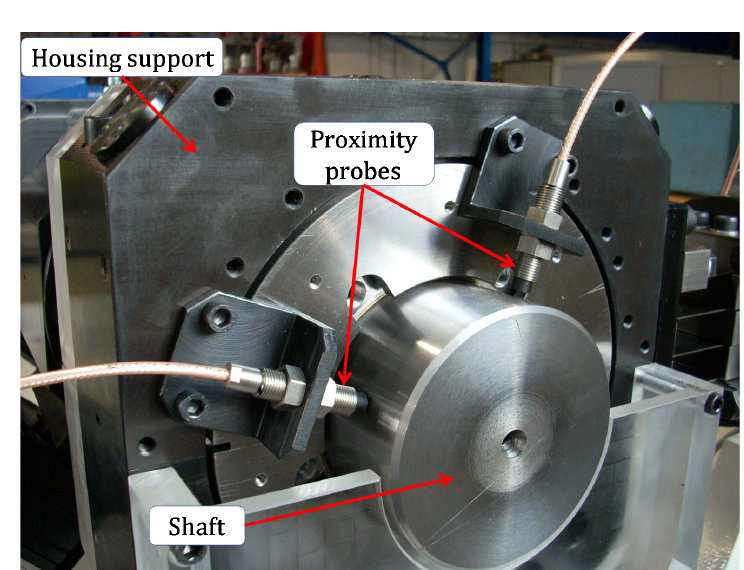
Figure 7. Proximity probes and pressure sensors installed on the bearing support.